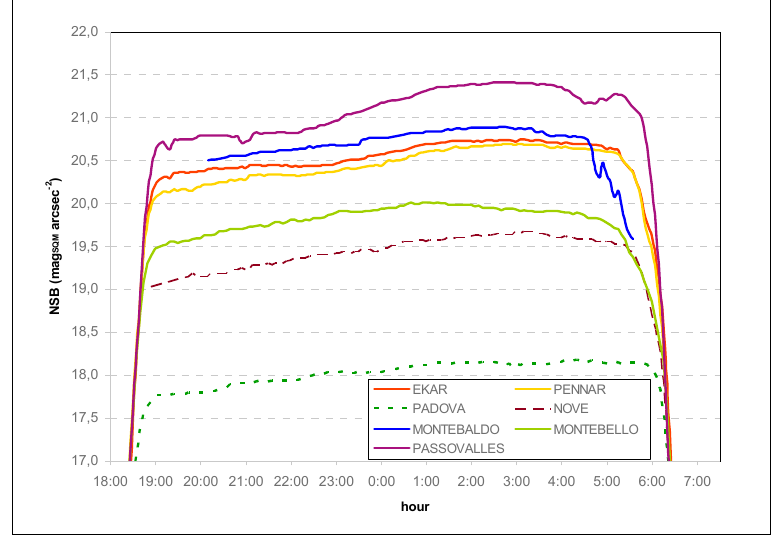
Figure 4. NSB data from 14 February 2018 to 15 February 2018. Table 4. Hourly increase rate of NSB between 21:00 and 01:00. Station